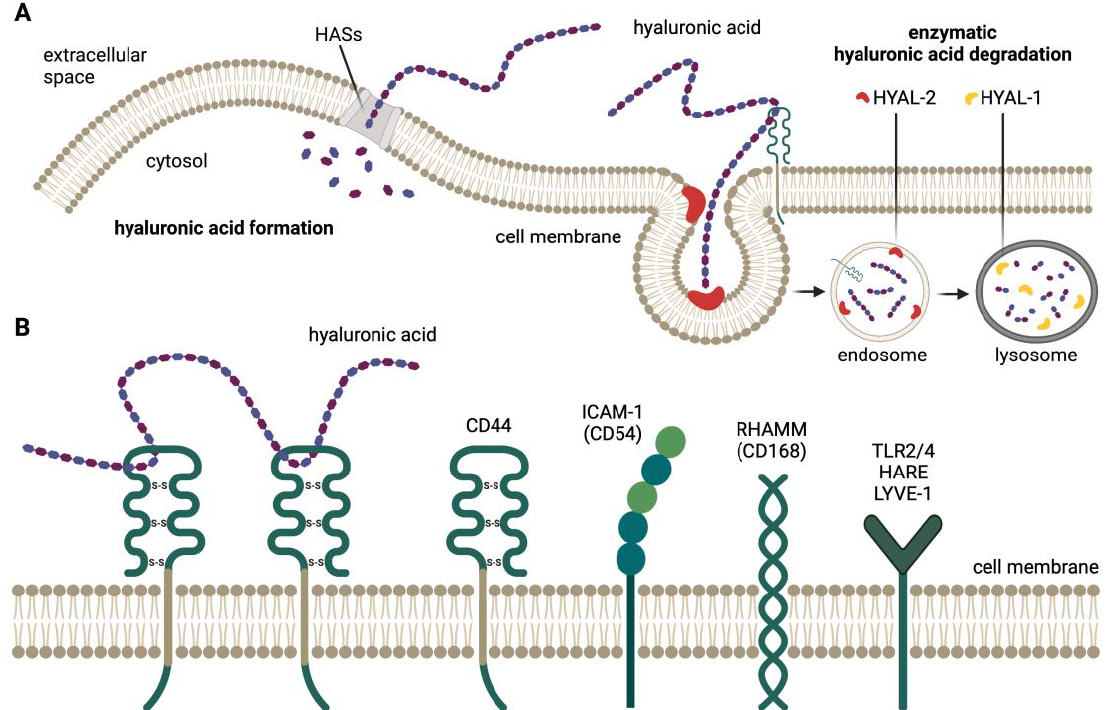
Figure 2. ( A ) Formation and enzymatic degradation of hyaluronic acid by hyaluronate synthases and hyaluronidases, respectively; and ( B ) interaction between hyaluronic acid and its receptors. Abbreviations used: CD44, cluster of differentiation 44; HARE, hyaluronan receptor for endocytosis; HASs, hyaluronate synthases; HYAL-1/2, hyaluronidase 1 or 2; ICAM-1, intercellular adhesion molecule 1; LYVE-1, lymphatic vessel endothelial hyaluronan receptor 1; RHAMM, receptor for hyaluronan-mediated motility; TLR2/4, Toll-like receptors 2 and 4. The figure was created with BioRender.com, accessed on 28 November